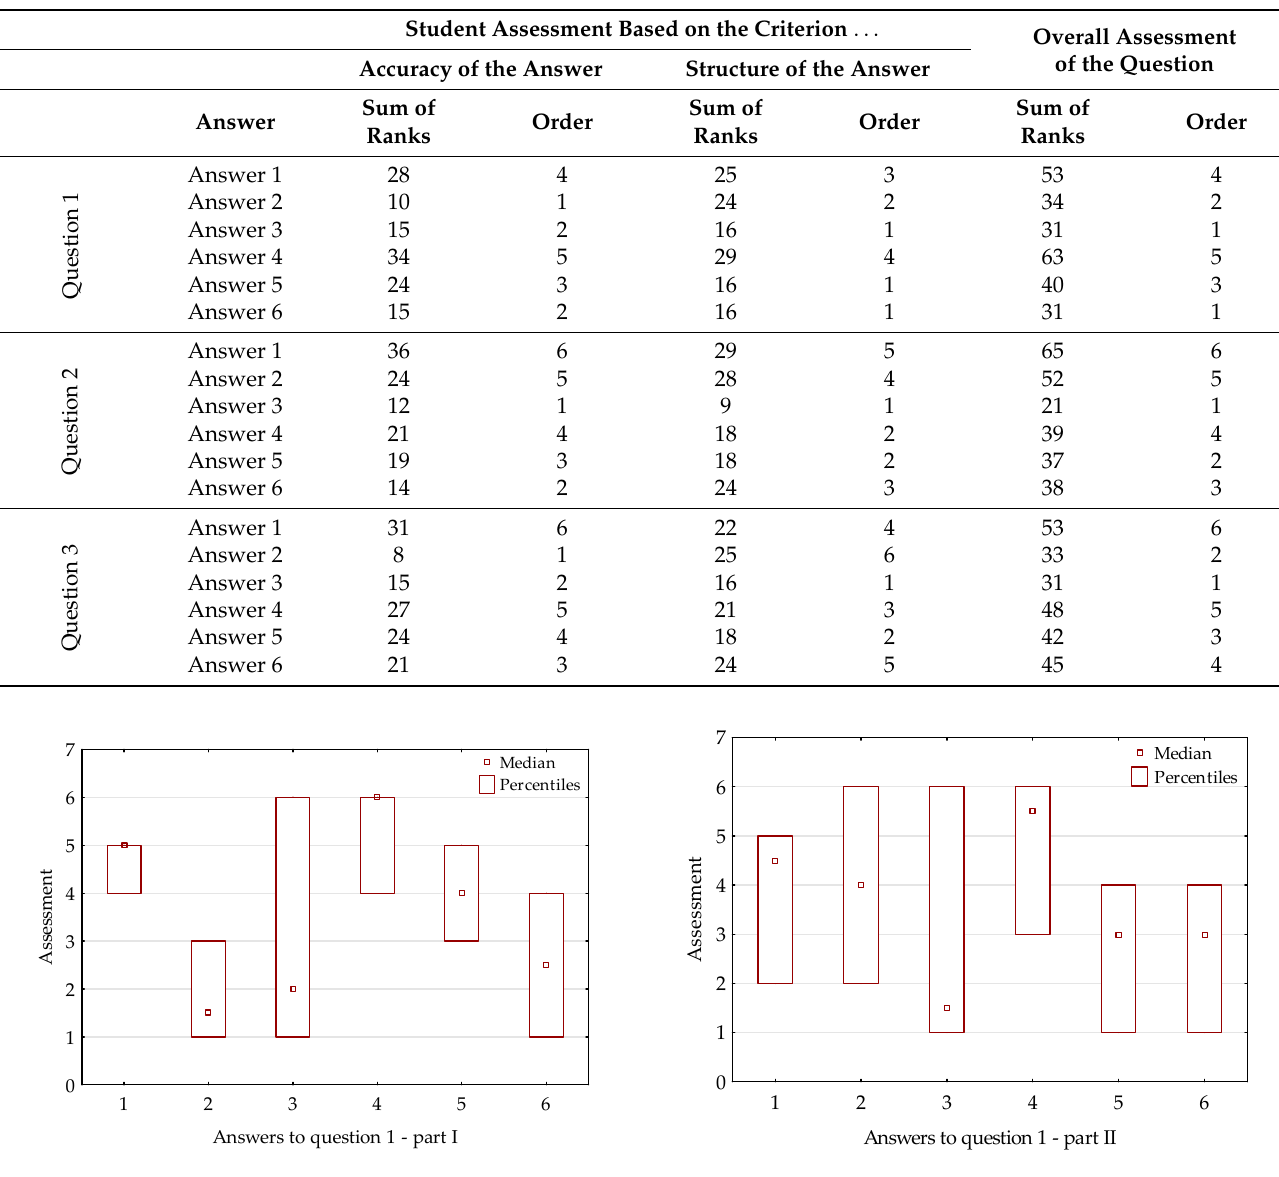
Table 2. Results of the assessment of answers to three research questions, developed by the ranking method. Student Assessment Based on the Criterion . . .